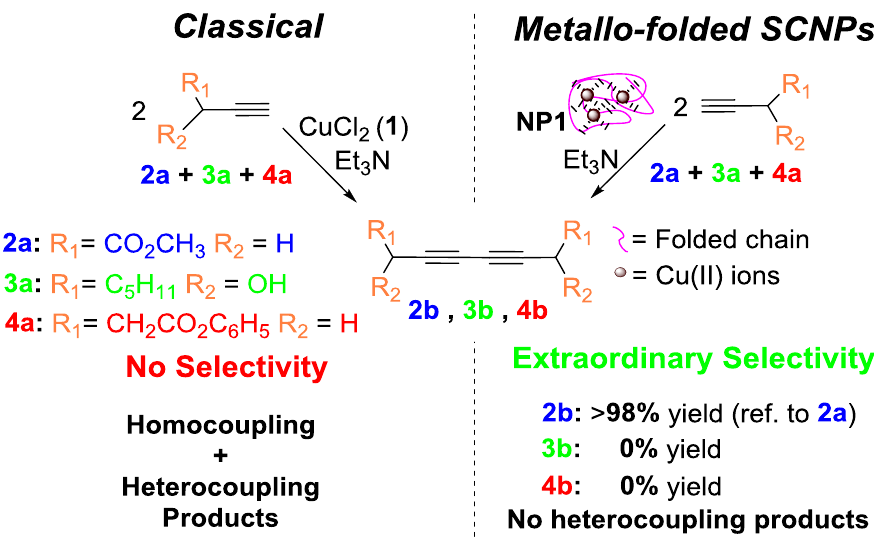
Figure 12. SCNPs synthesized via the “concurrent binding/folding” approach based on metallo-folded polymer chains containing complexed Cu(II) ions, showing catalytic specificity during the oxidative coupling of mixtures of chemically related terminal acetylene substrates (reprinted from [14] with permission, Copyright American Chemical Society, 2014).